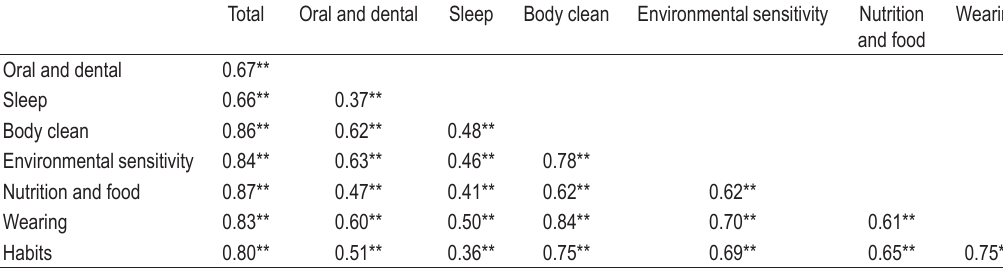
TABLE 5. Correlation matrix of subgroups and total scores for ACHS-P Total Sleep Body clean Environmental sensitivity Nutrition